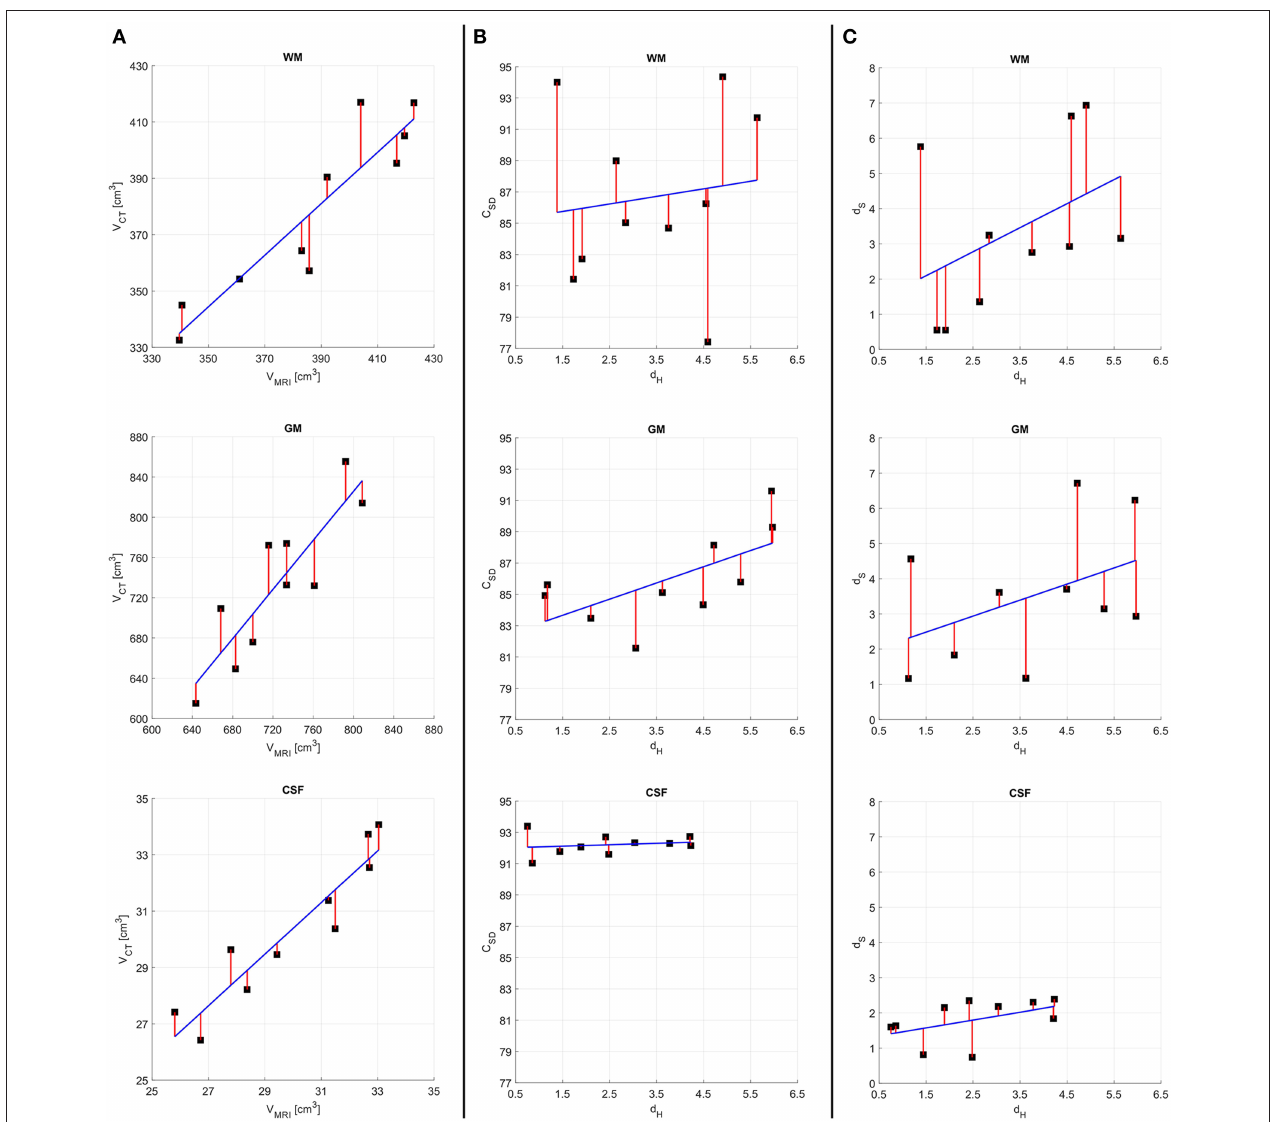
FIGURE 3 | Results of quantitative analysis for concussion victims. For all quantities plotted, the regression line of best fit (blue) and residuals (red) are shown on plots with identical ranges along both x and y , to facilitate comparison. (A) MRI- vs. CT-derived volumes. (B) The Hausdorff distance d H vs. the Sørensen-Dice coefficient C SD . (C) The Hausdorff distance d H vs. the stretching distance d S . Quantities pertaining to WM, GM, and CSF are displayed in the first, second, and third rows,